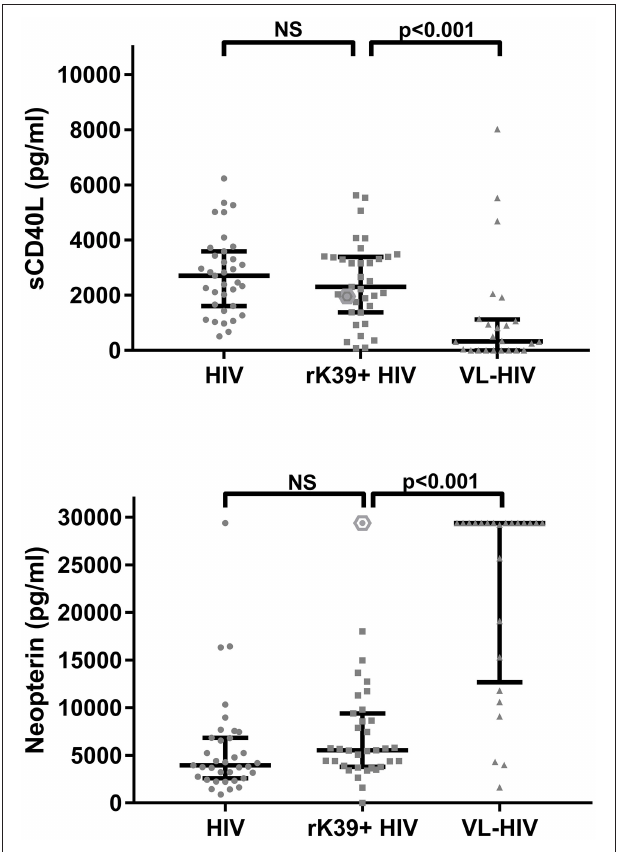
FIGURE 1 | Dot plot of serum sCD40L (top) and neopterin (bottom) concentrations per Leishmania infection status group in HIV patients. Hexagon indicates single HIV patient that developed VL 9 months later.